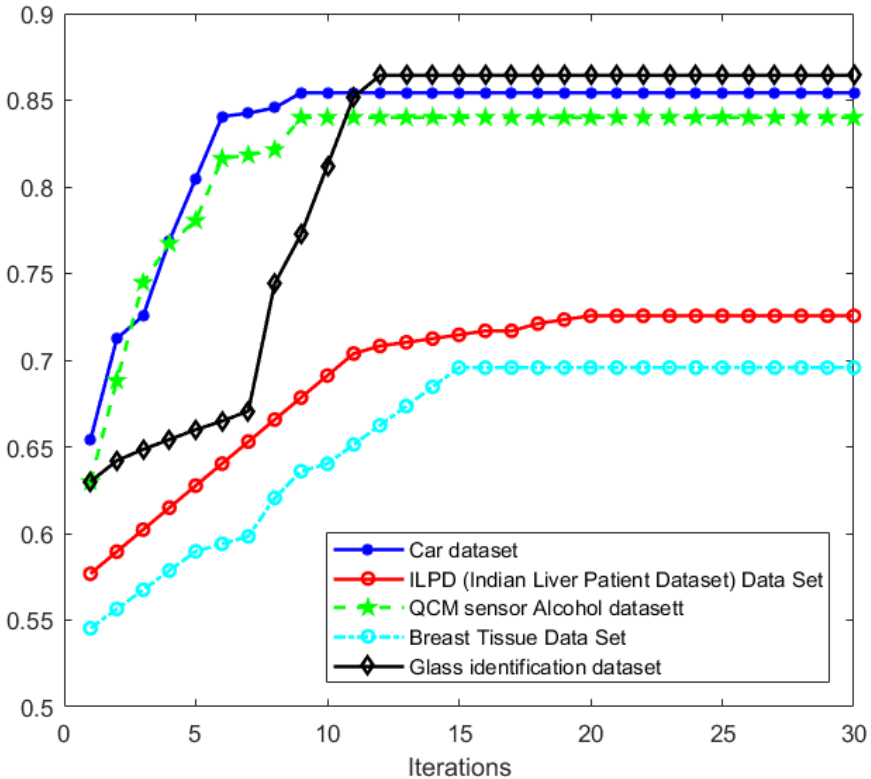
Figure 8. The process of best fitness change with increasing number of iterations on multi-class